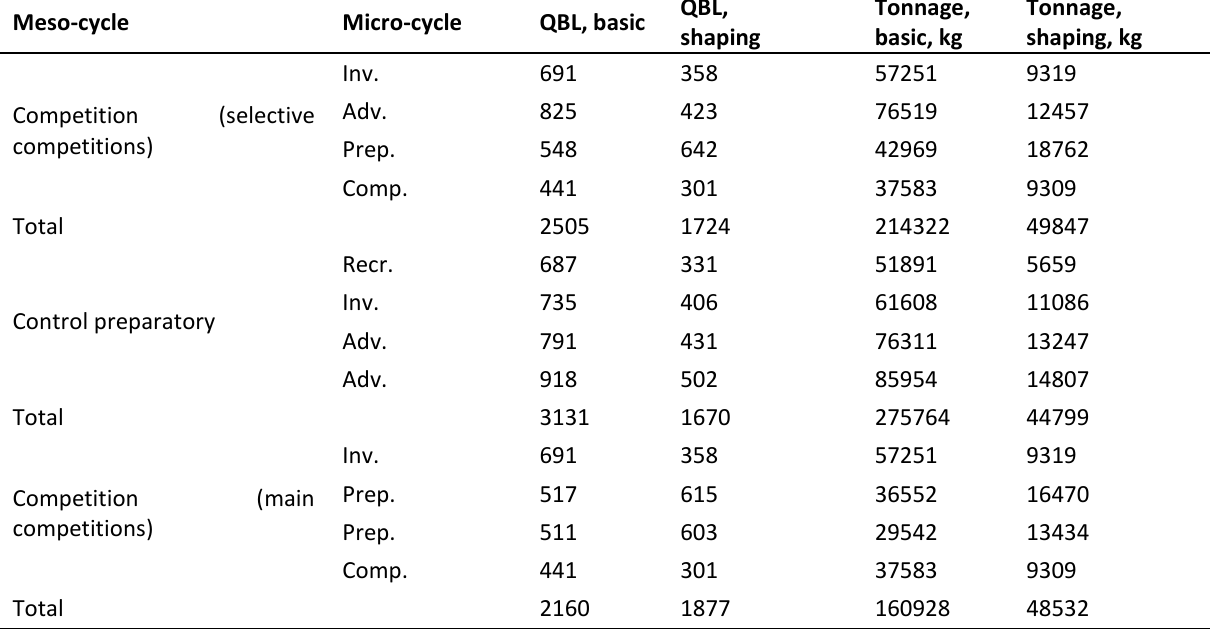
Table 5. Quantity of barbell lifting and load in kg for EG in competition period Meso-cycle Micro-cycle QBL, basic